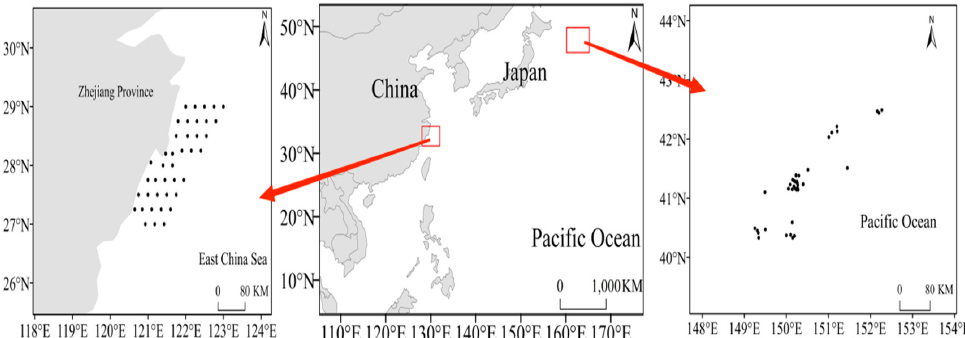
Figure 1. Sample stations for Chub mackerel in the coastal waters off the northwest Pacific Ocean .